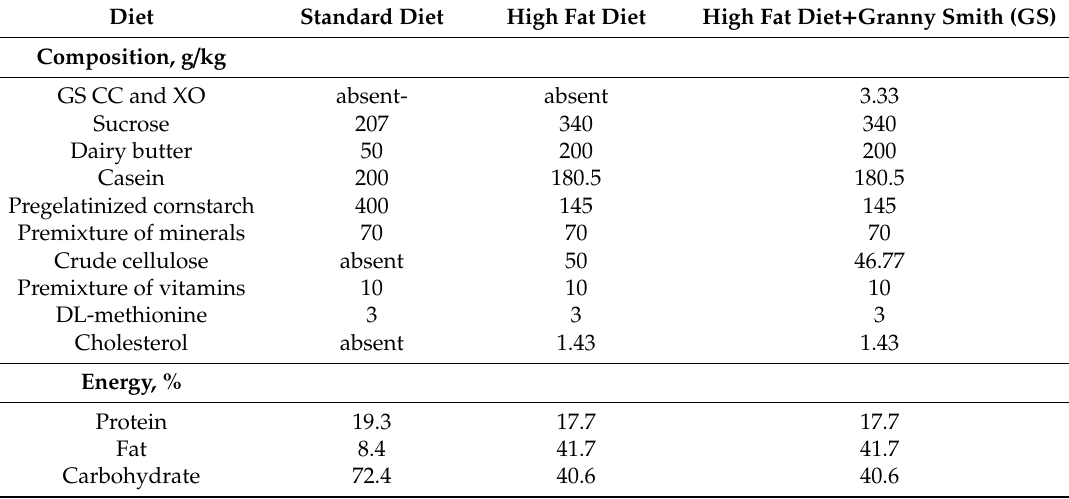
Table 1. Composition of diets used in the present